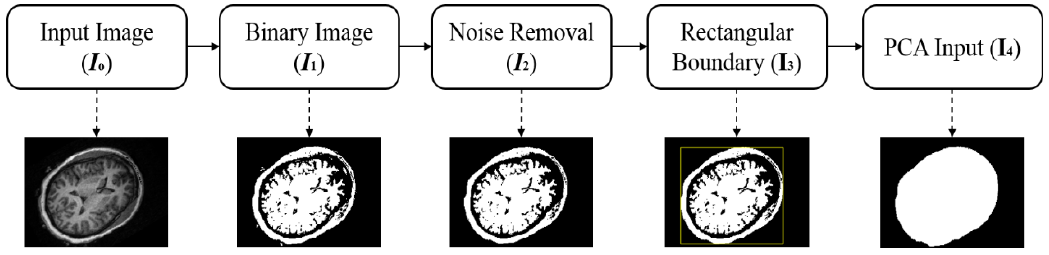
Figure 2. Steps for noise removal and region of interest (ROI) extraction.